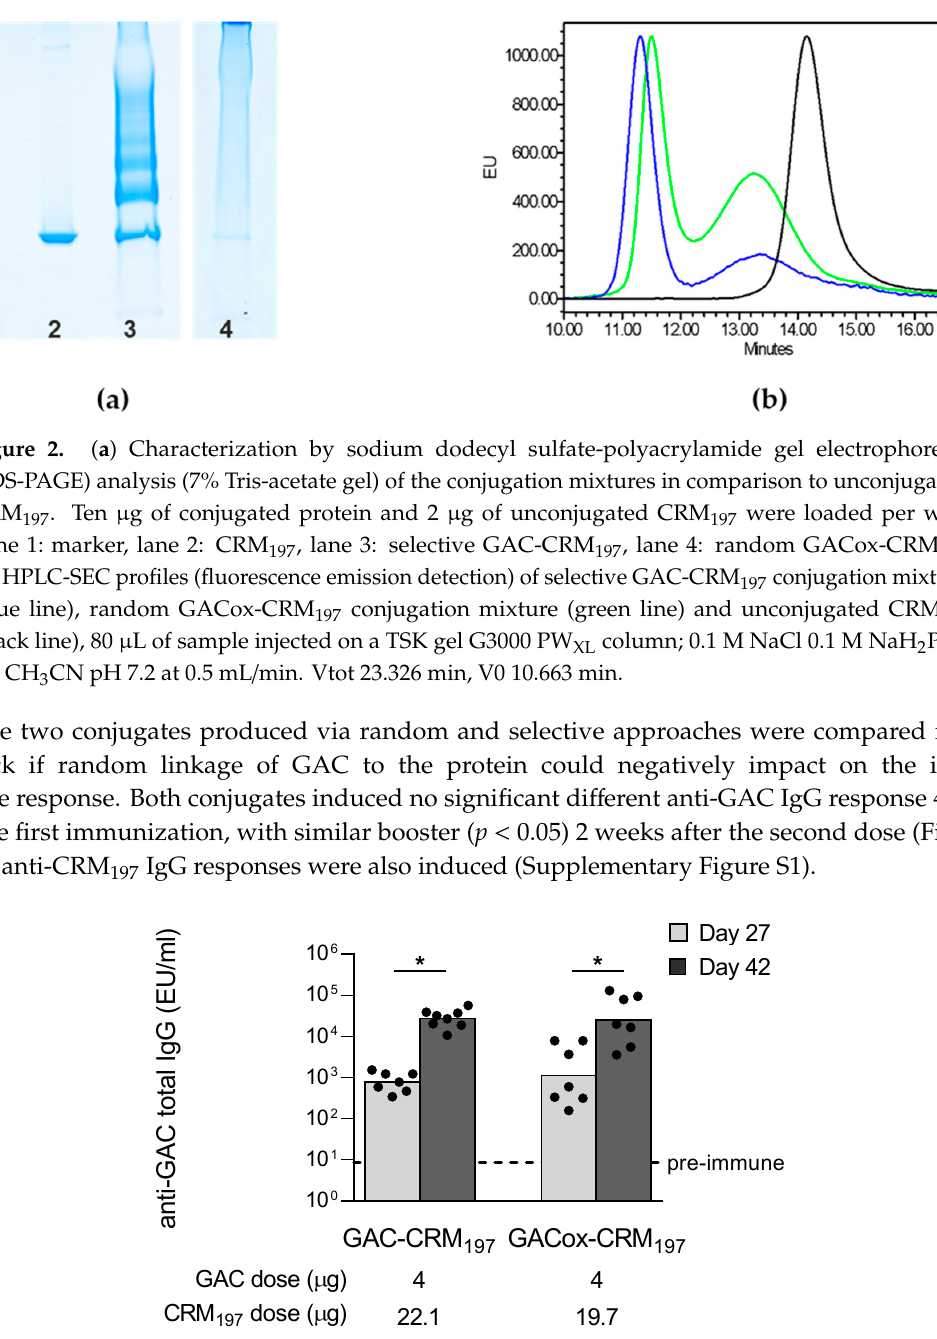
Figure 3. Immunogenicity of GAC when conjugated to CRM 197 through different chemistries. CD1 mice were immunized intraperitoneally (i.p.) at day 0 and 28 with 4 µg GAC/dose formulated with 2 mg/mL Alhydrogel. Summary graph of anti-GAC specific IgG geometric mean units (bars) and individual antibody levels (dots) is reported (GAC-HSA used as coating antigen). Not enough sera was available at day 27 for one mice immunized with GAC-CRM 197. Mann-Whitney two-tailed test was performed to compare the response induced by the two immunization groups ( p > 0.05) whereas Wilcoxon test was performed to compare the responses for each group at day 27 and day 42 (* p < 0.05).